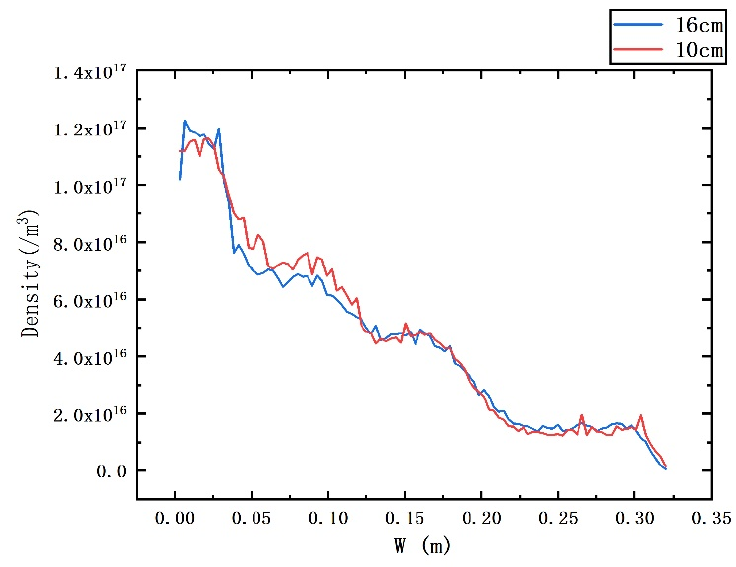
Figure 9. Gas molecules’ density distribution along the inlet direction when L 1 = 10 and 16 cm.